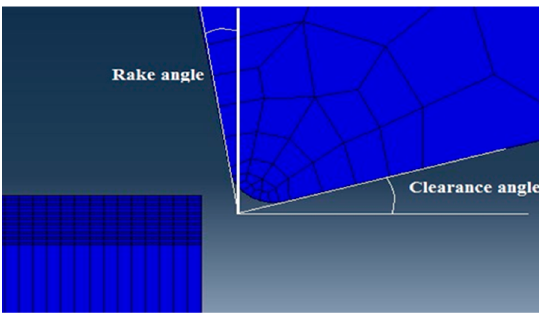
Figure 3. Side view of the cutting tool–workpiece assembly showing the tool angles.